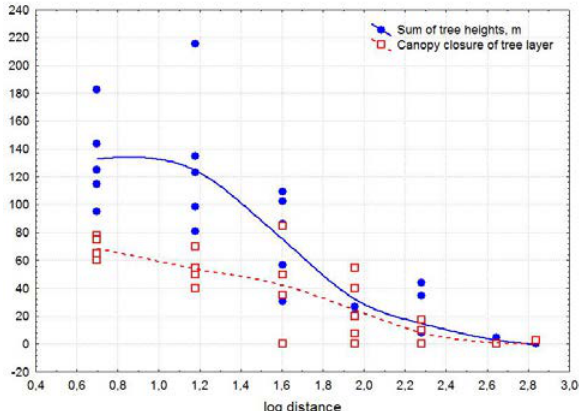
Figure 11. Relationships between the sum of tree heights and tree layer canopy closure, and log- distance from the cutoff ditch.